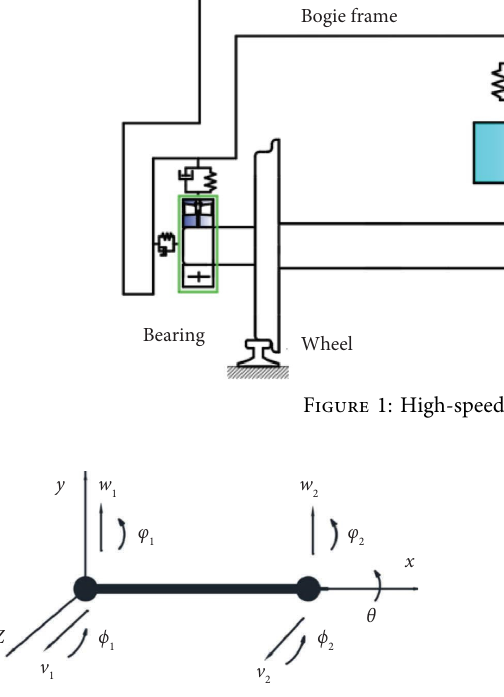
Figure 2: Timoshenko beam shaft